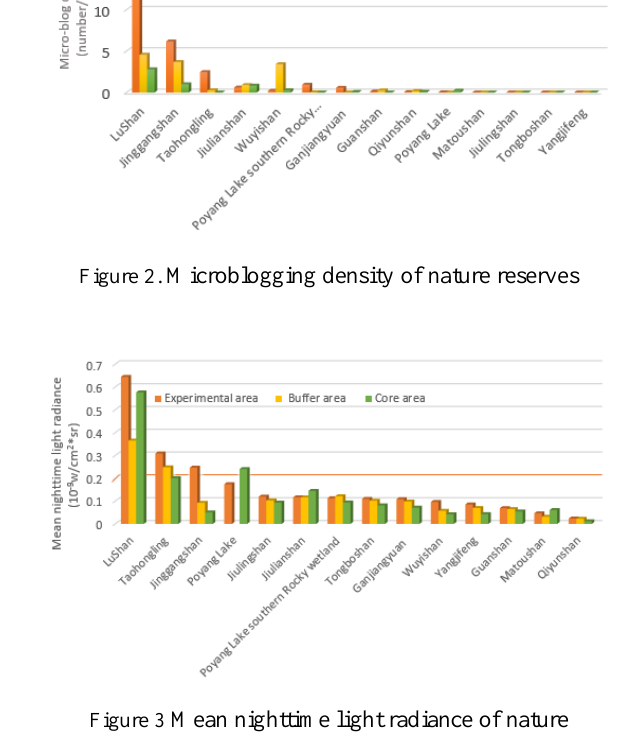
Figure 3 Mean nighttime light radiance of nature